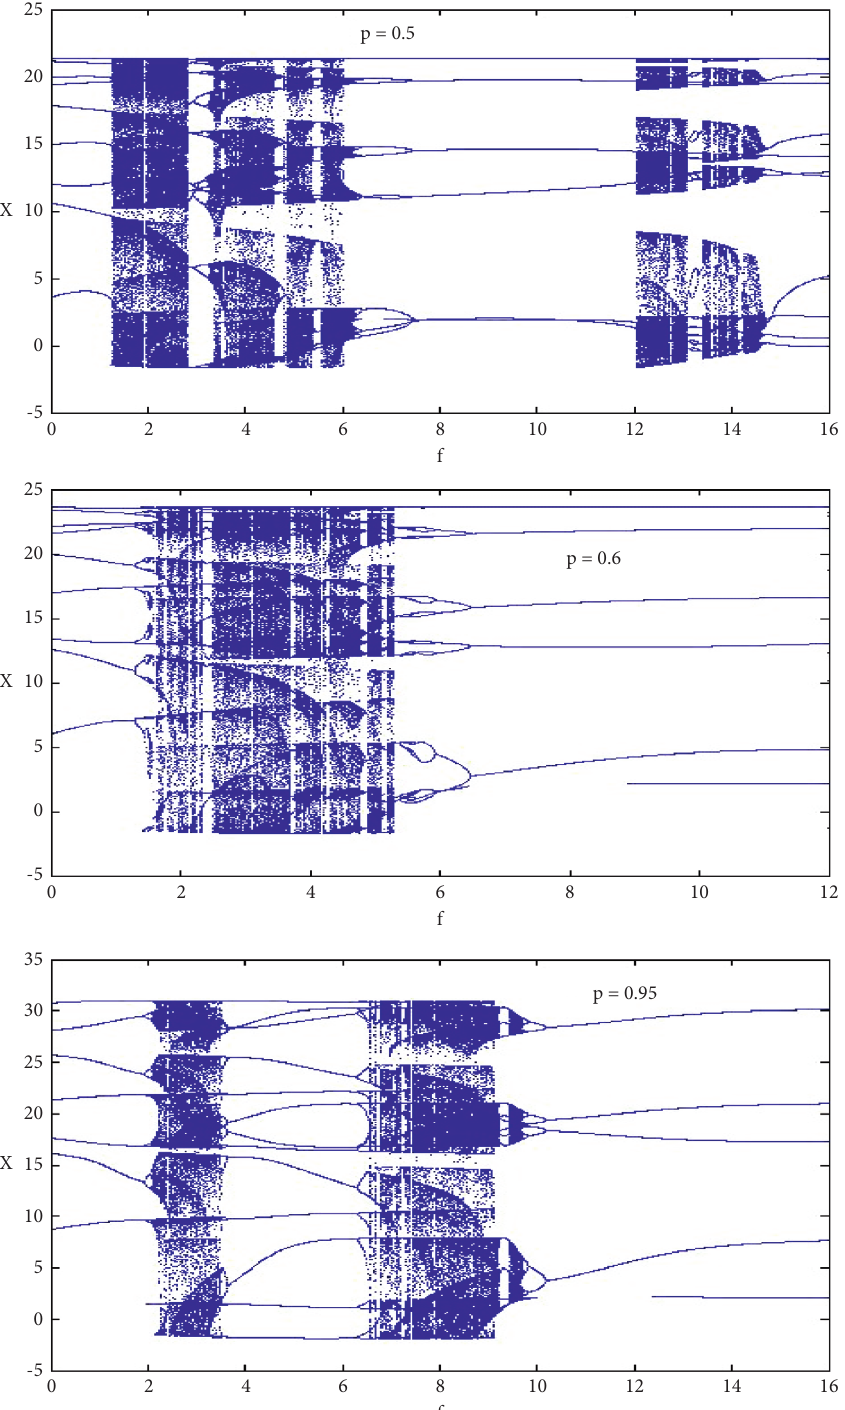
Figure 13: Effect of p on the bifurcation diagram of Figure 11 of the new chemical system obtained under initial conditions (0.5,